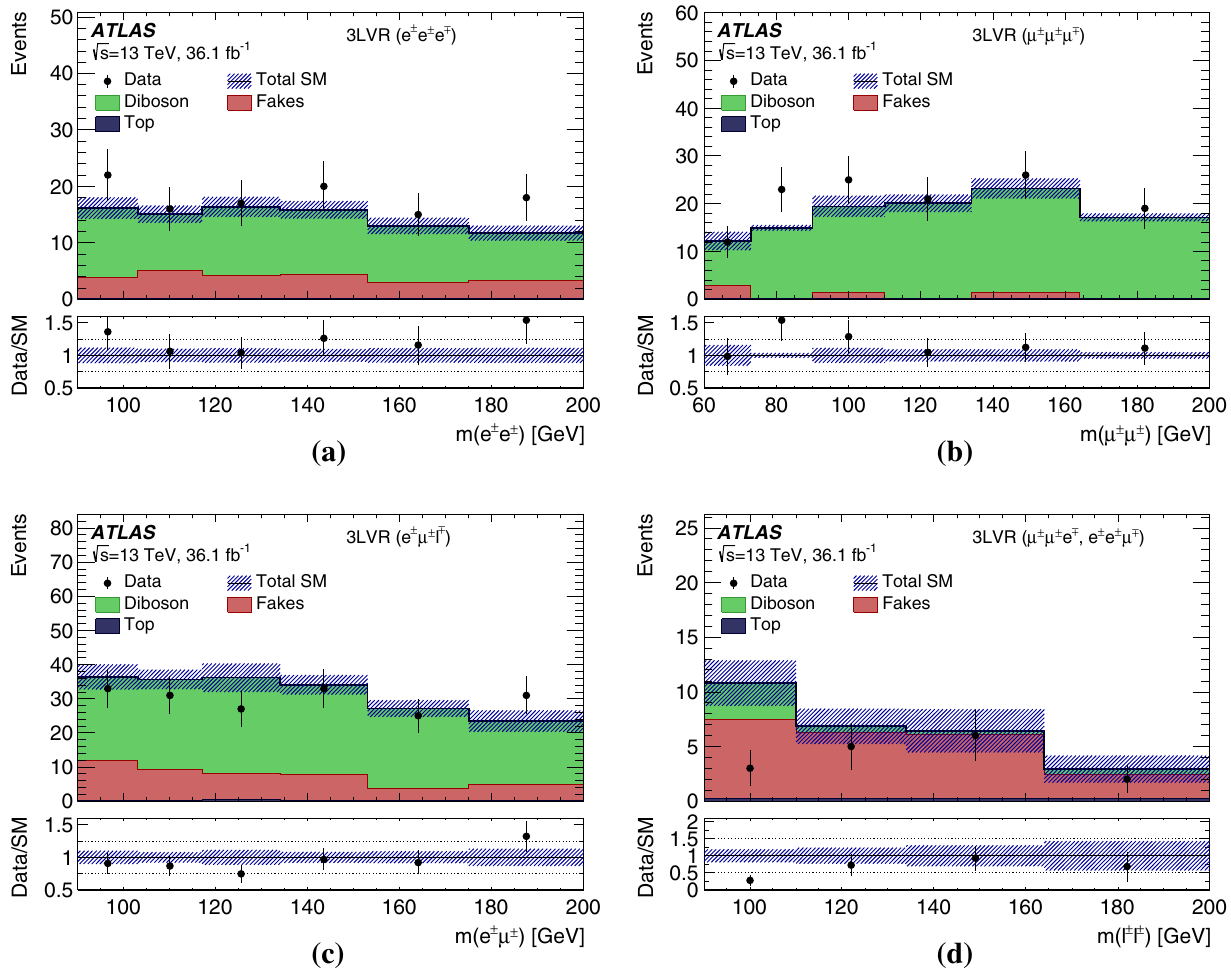
Fig. 5 Distribution of dilepton mass for data and SM background pre- dictions in three-lepton validation regions: a the three-electron valida- tion region, b the three-muon validation region, c the 3LVR with an electron–muon same-charge pair ( e ± μ ± (cid:3) ∓ ), and d the 3LVR with a